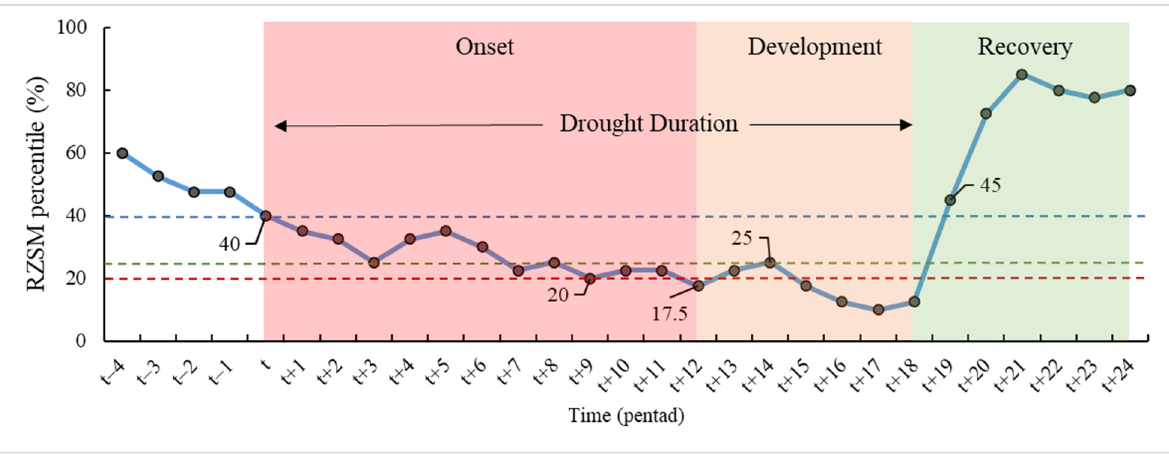
Figure 2. Schematic diagram of drought identification. The sample is located at 33.5°N,